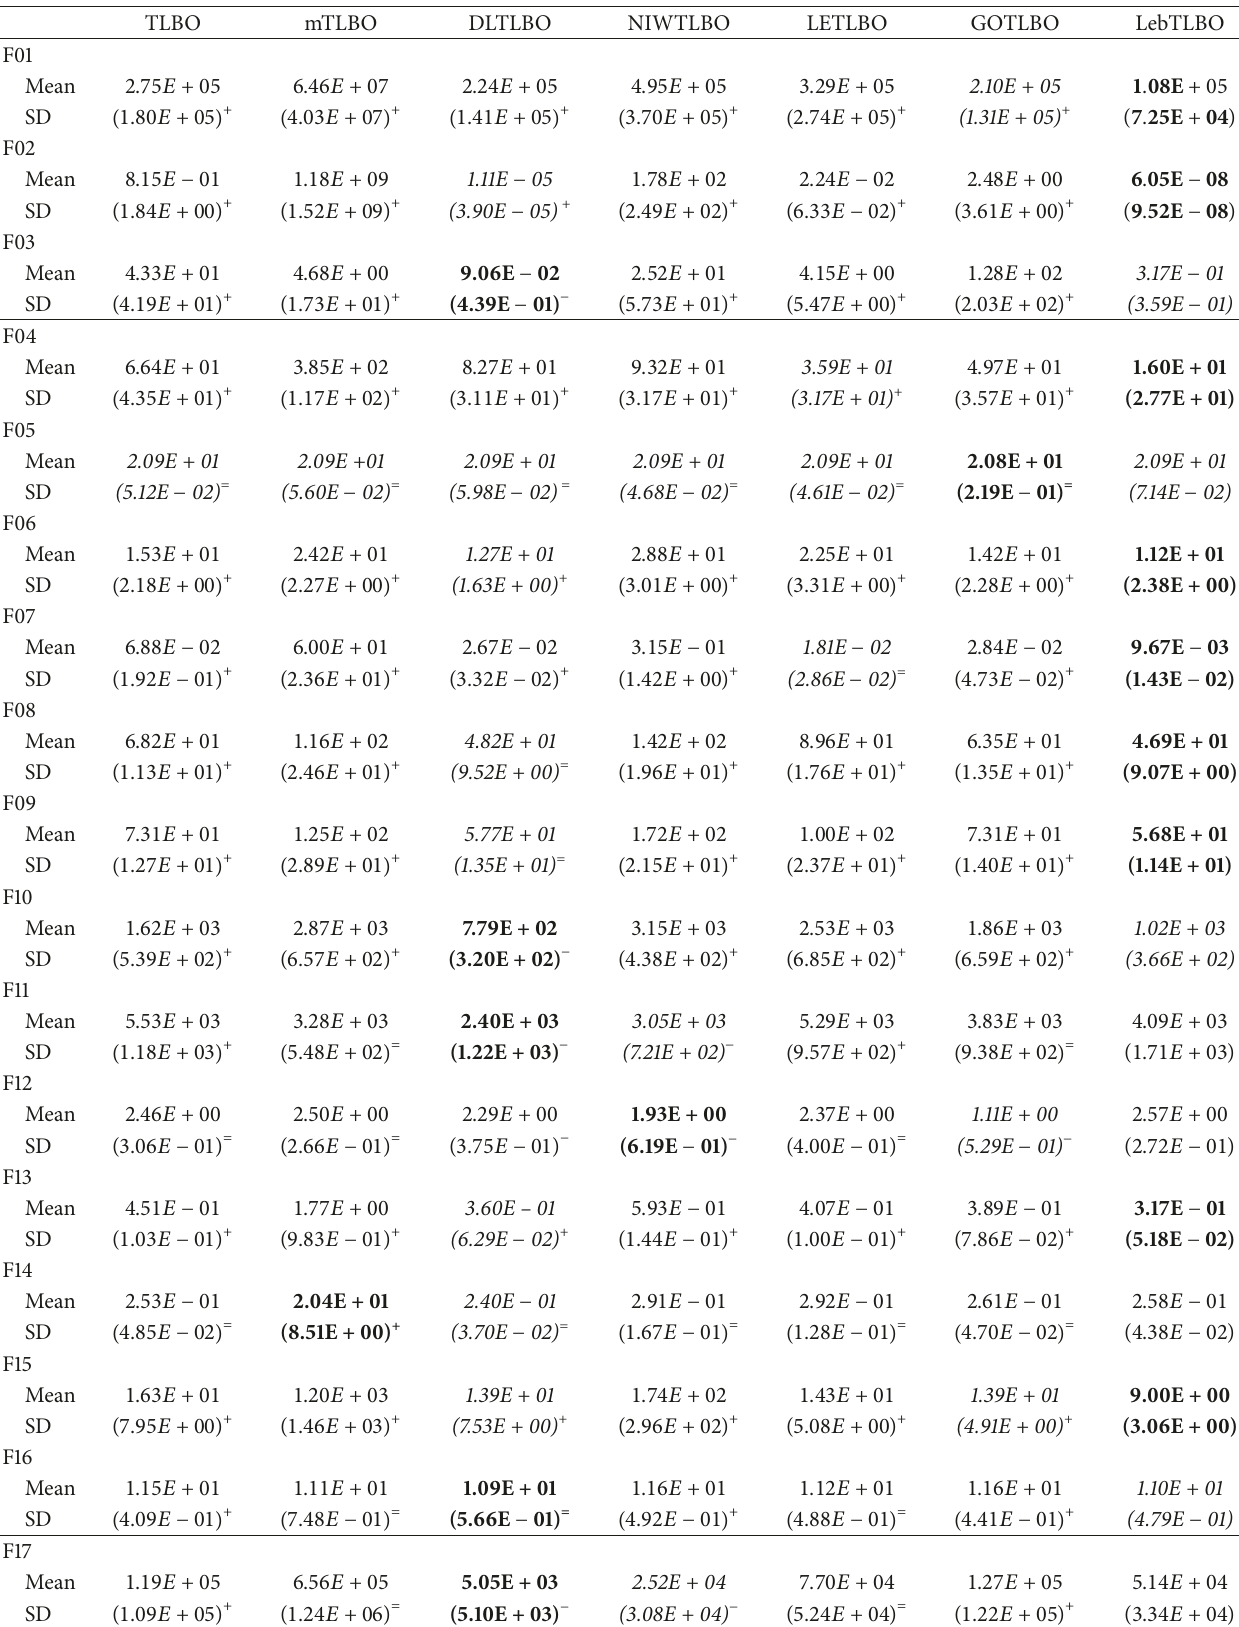
Table 2: Comparison between LebTLBO and other TLBO